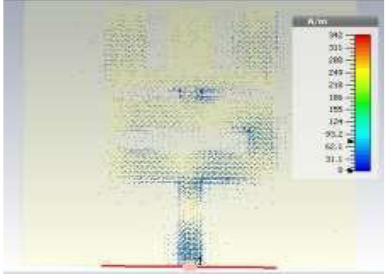
Figure 5.3: Surface current at 4.53GHz.